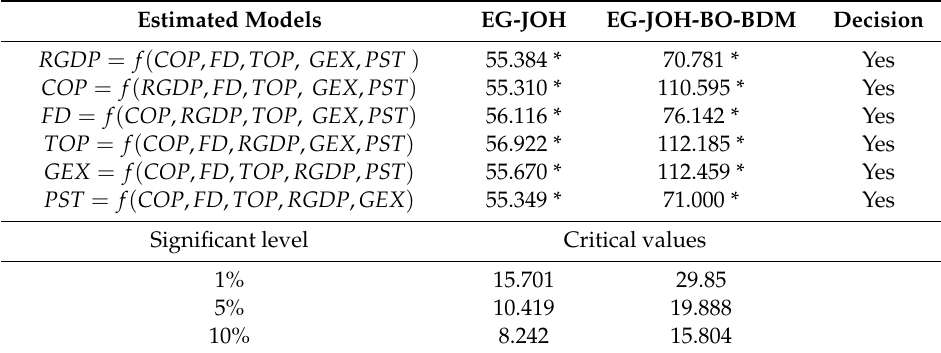
Table 7. The Bayer and Hanck (2013) co-integration test